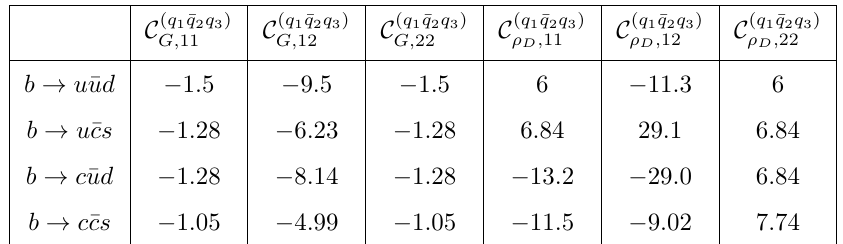
Table 1 . Numerical values of the coefficients C ( q 1 ¯ q 2 q 3 )